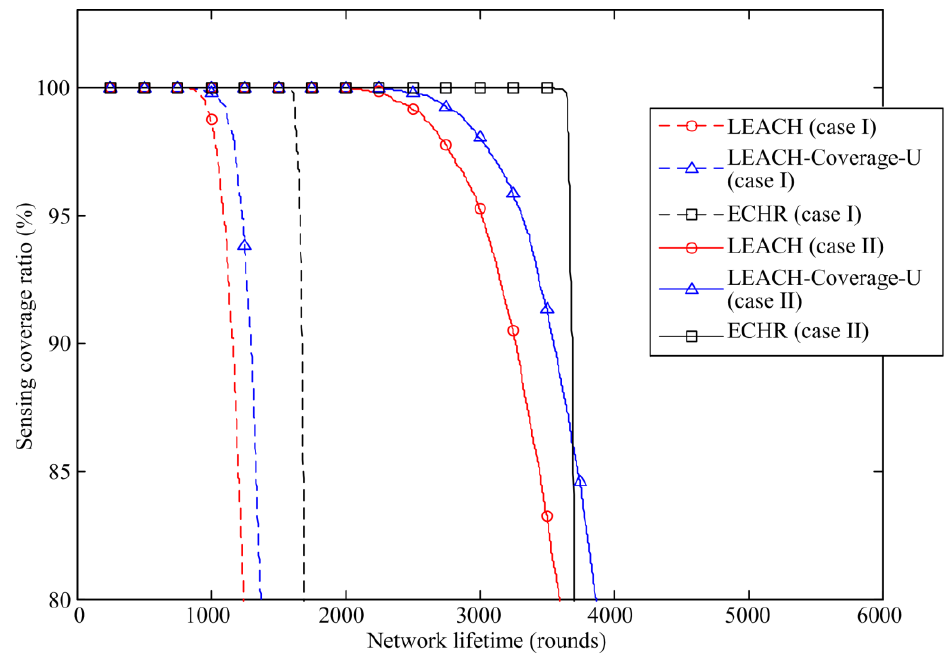
Figure 9. Comparison of the coverage ratio of the proposed ECHR protocol with those of other